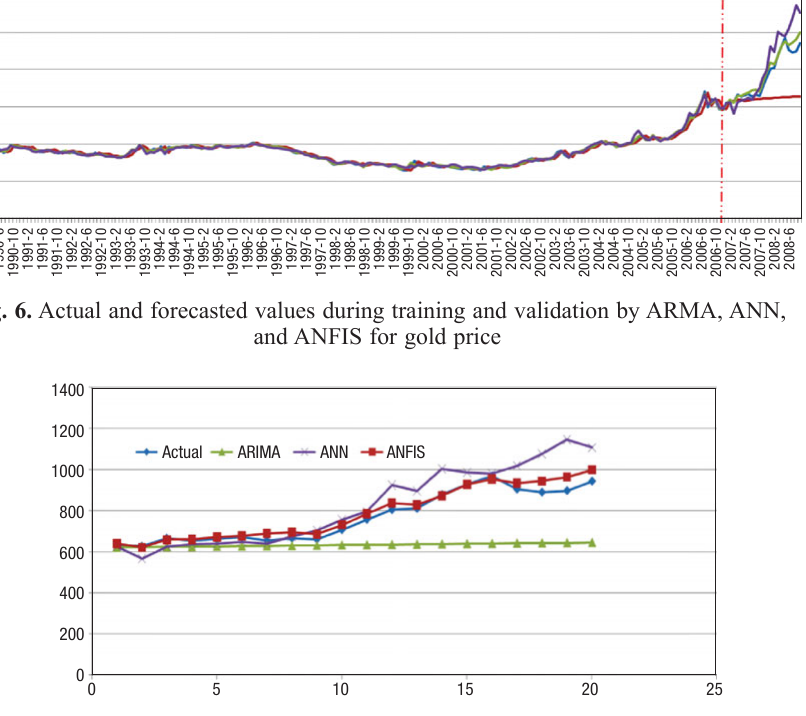
Fig. 7. The variation of the values predicted by ARIMA, ANN, and ANFIS models during validation period, from the actual